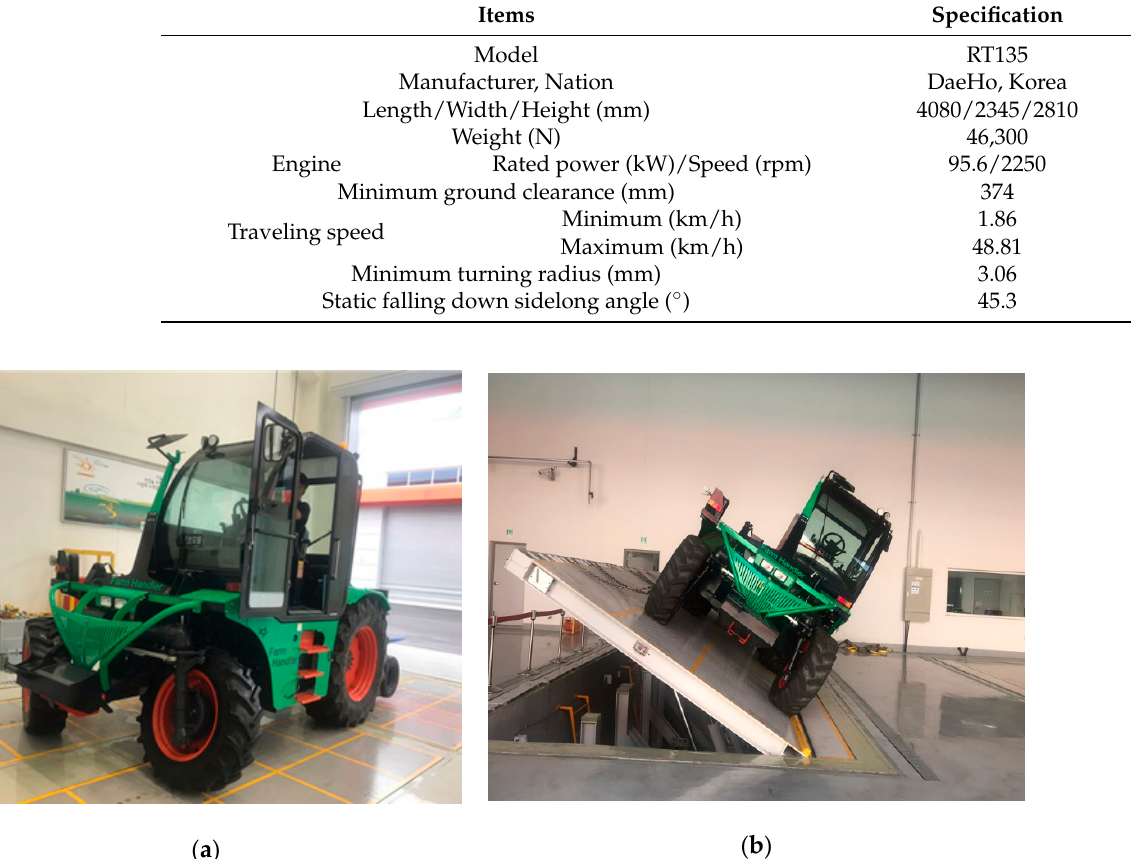
Figure 2. Pictures of the performance tests: ( a ) Minimum turning radius test; ( b ) Static falling down sidelong angle test.